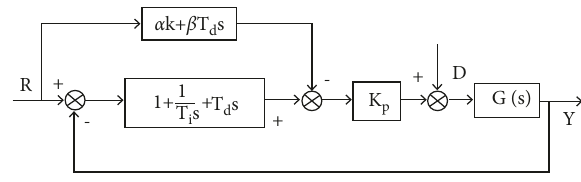
Figure 1: FF type 2-DOF PID control system